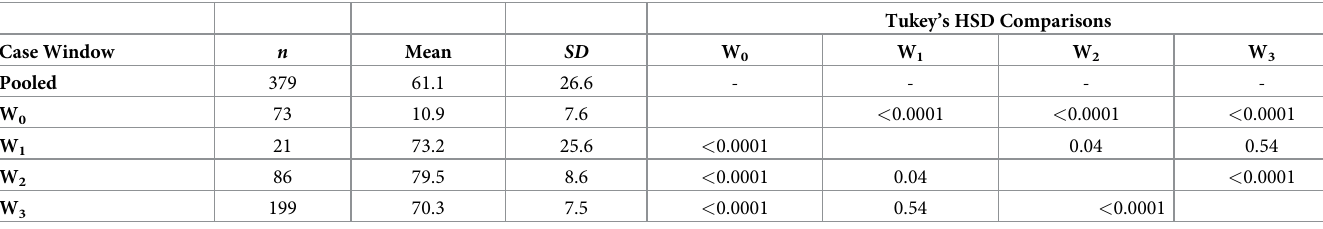
Table 4. One-way analysis of variance of the stringency index by case window,